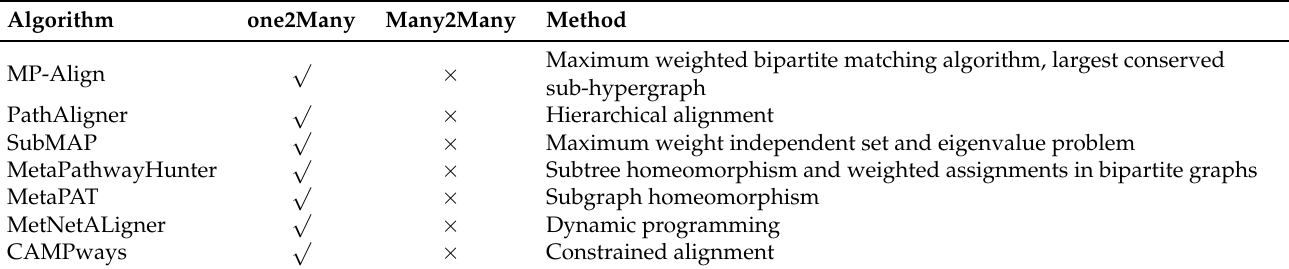
Table 3 summarizes the available types of pathway alignment algorithms. Table 3. Pathway alignment